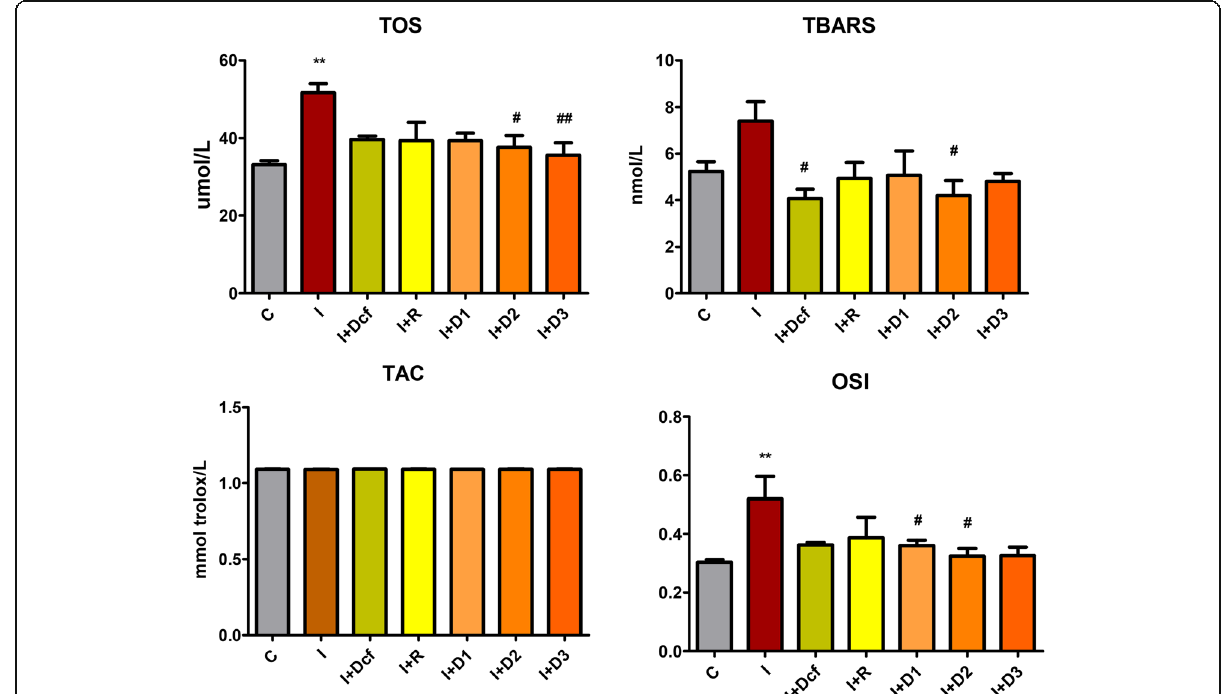
Fig. 4 In vivo antioxidant effects of H. capitatum extract on TOS, TBARS, TAC and OSI levels in serum . Data represent mean ± SEM; One-way ANOVA followed by Bonferroni ’ s Multiple comparison test; * Significant at p < 0.05; **Significant at p < 0.01; ***Significant at p < 0.00 – compared with C group; # Significant at p < 0.05; ## Significant at p < 0.01; Significant at p < 0.00 – compared with I group; [C- Control; I- Inflammation; Dcf- Diclofenac; I + R- Inflammation + Rutin; I + D1 - Inflammation + Dose 1 of H. capitatum extract; I + D2 - Inflammation + Dose 2 of H. capitatum extract;